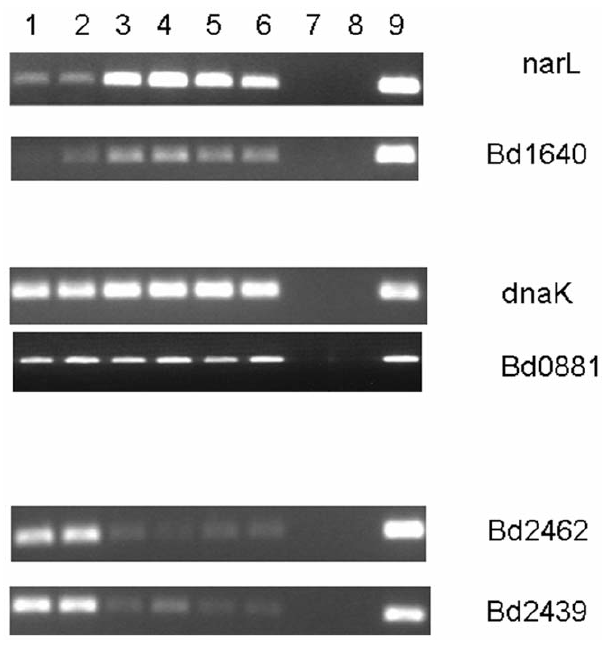
Figure 4. RT-PCR to show that differential expression is not HI- strain specific. RT-PCR on matched amounts of RNA to compare host- dependent attack phase (sample 1) and 4 hours post-infection (2) with 4 different HI strains HID13 (3), HID2 (4), HID22 (5) and HID26 (6) along with controls of E. coli prey RNA (7), no template (8) and HD100 genomic DNA as template (9). Primers were designed against 2 genes upregulated in HI phase ( narL and Bd1640), 2 genes constitutively expressed in both phases ( dnaK and Bd0881) and 2 genes with